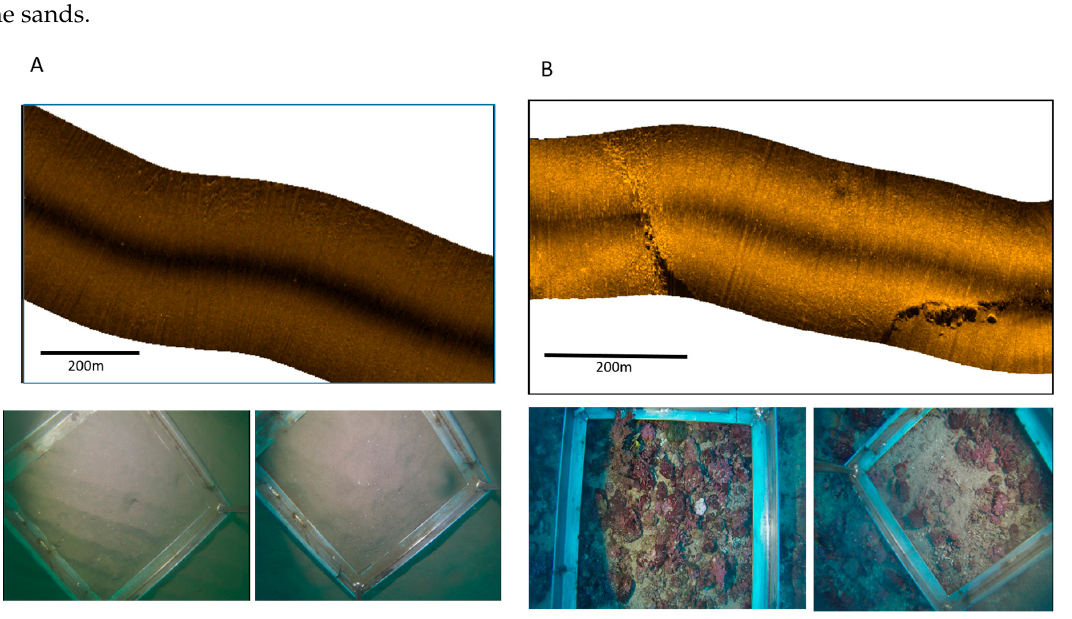
Figure 5. Side scan sonar images and dropcamera seabed frames: ( A ) Terrigenous fine sediment facies characterized by a homogeneous and low backscatter signal; ( B ) rhodoliths characterized by a high backscatter signal with acoustic shadows. For images location, see Figure 4.